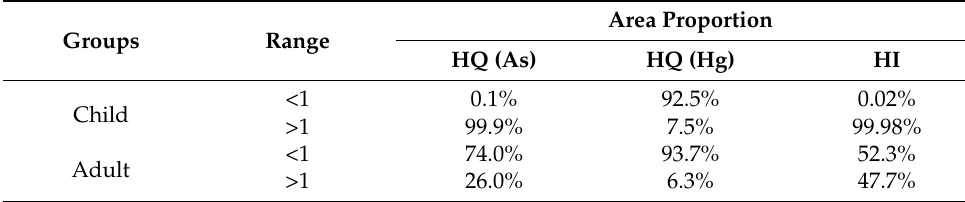
Table 7. Area proportion of non-carcinogenic